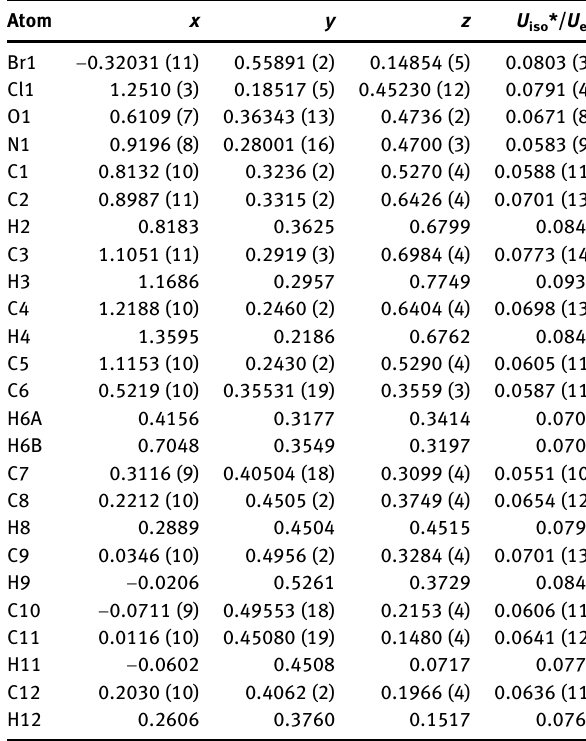
Table  : Fractional atomic coordinates and isotropic or equivalent isotropic displacement parameters (Å 